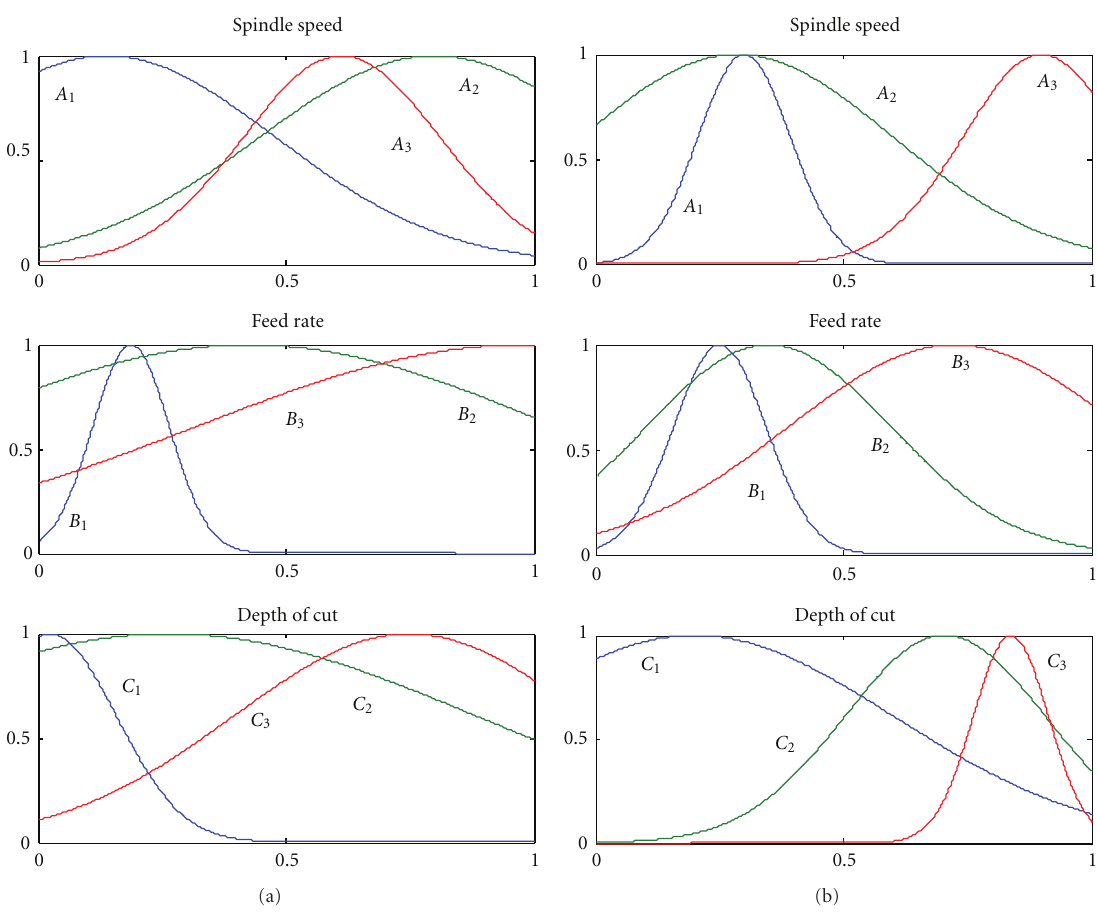
Figure 11: Membership functions of FO (a) and ZO (b) Sugeno fuzzy models after training with